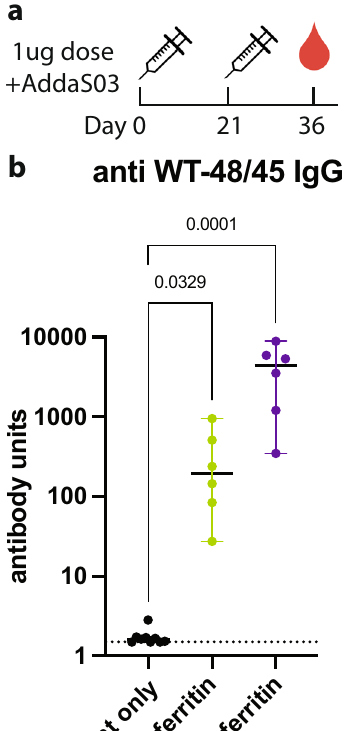
Fig. 4 Two low-dose immunizations with a Pfs48/45 D3 immuno- gen nanoparticle elicits high TRA. a Immunization and blood draw schedule for Wistar rats. b IgG antibody titers to WT Pfs48/45 D3. Medians and 95% con fi dence intervals are displayed. Dashed line indicates the limit of detection. P -values displayed were calculated using a Kruskal – Wallis test followed by a Dunn ’ s comparison to adjuvant only, corrected for multiple comparisons. c TRA of serum from immunized rats with median values indicated. Dashed line indicates 0% TRA relative to adjuvant only serum. P -value displayed was calculated using a two-tailed Mann – Whitney